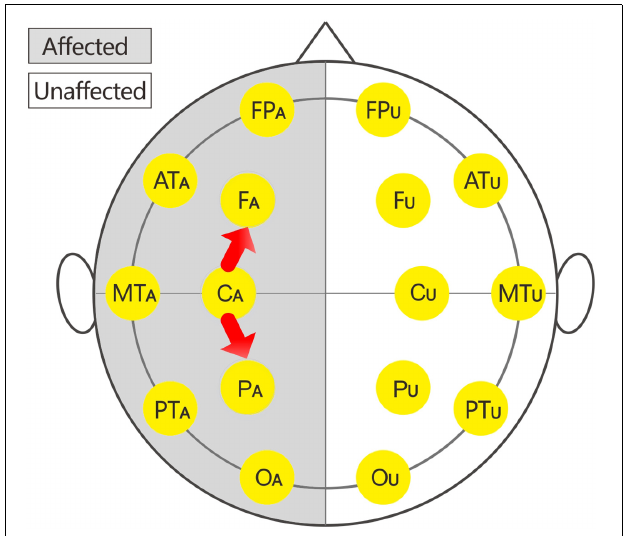
FIGURE 6 | Changes in the C-ApEn indices under the unaffected painful stimulus